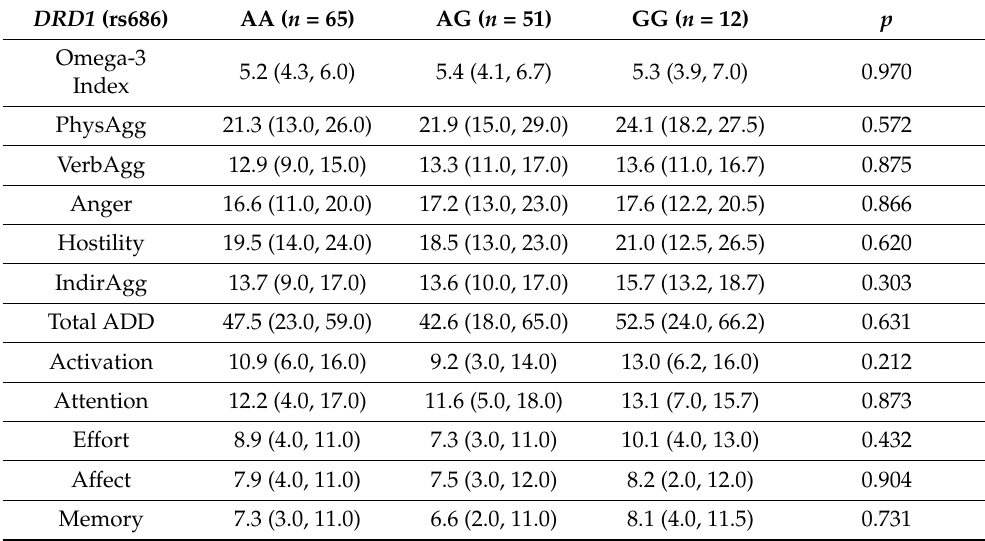
Table 2. DRD1 genotypes analysis according to Omega-3 Index and neuropsychological